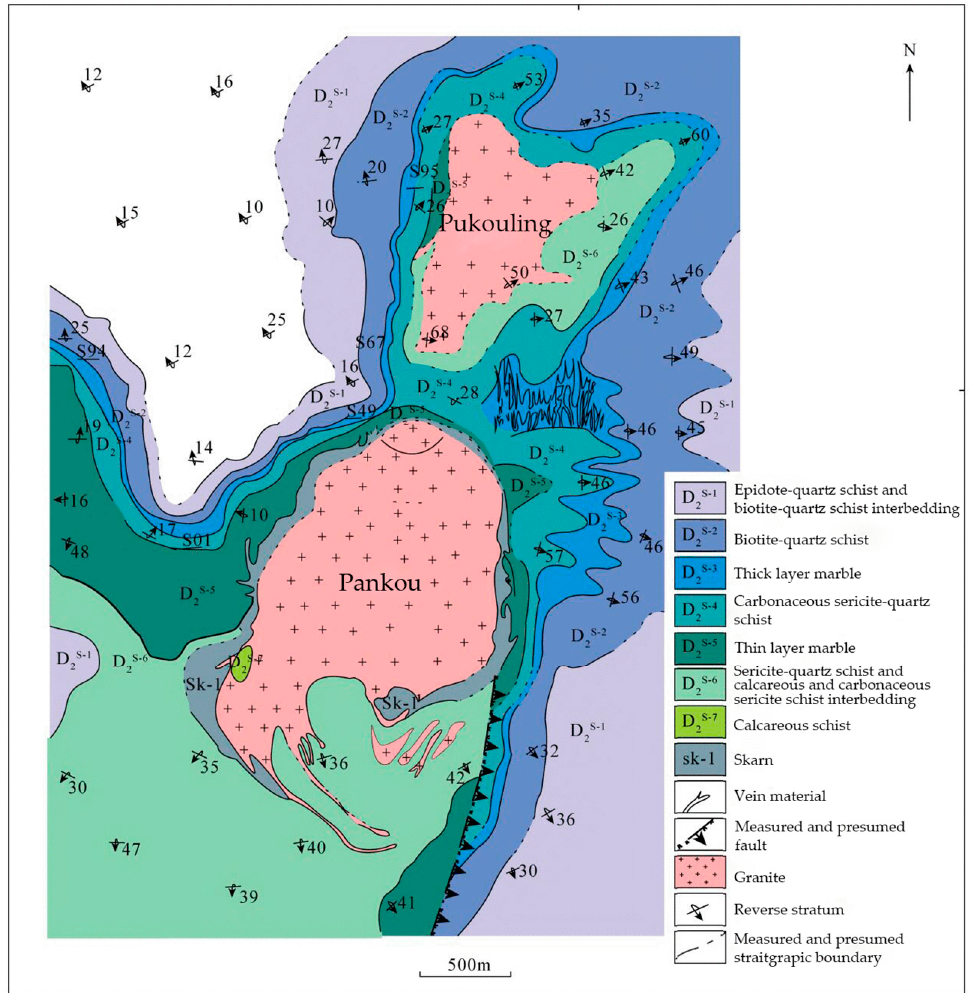
Figure 1. Geological sketch map of the Xuebaoding W-Sn-Be deposit. Modified from [23,24]. Repro- duced with permission from Zhou K.C.; Qi L.J.; Xiang C.J.; Feng Q.M.; Wan J.S.; Journal of Mineralogy and Petrology; published by Chengdu University of Technology, 2002 and Zhu X.X.; Liu Y.; Rock and Mineral Analysis; published by Science Press, 2021.